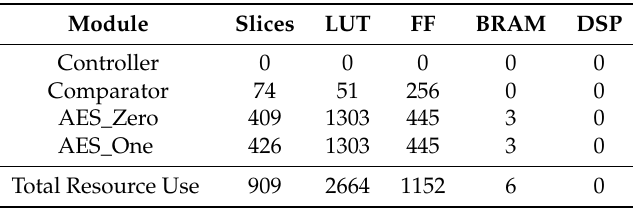
Table 1. Logic Use Summary for IDF and Non-IDF